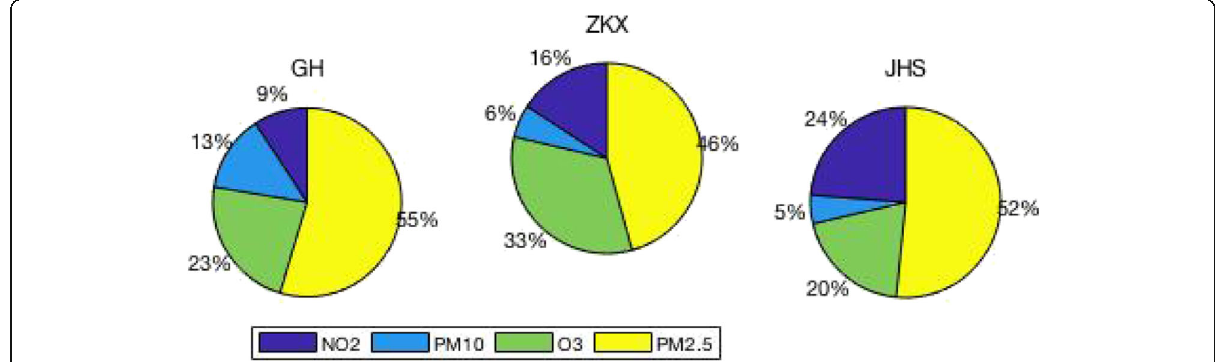
Fig. 3 Percentage of AP impact on AQIs. It provides the composition and percentages of determinative pollutants in the AQIs. The first pie is the result of the GH locality, the second pie is the result of the ZKX locality, and the third pie is the result of the JHS locality. Different colors represent different air